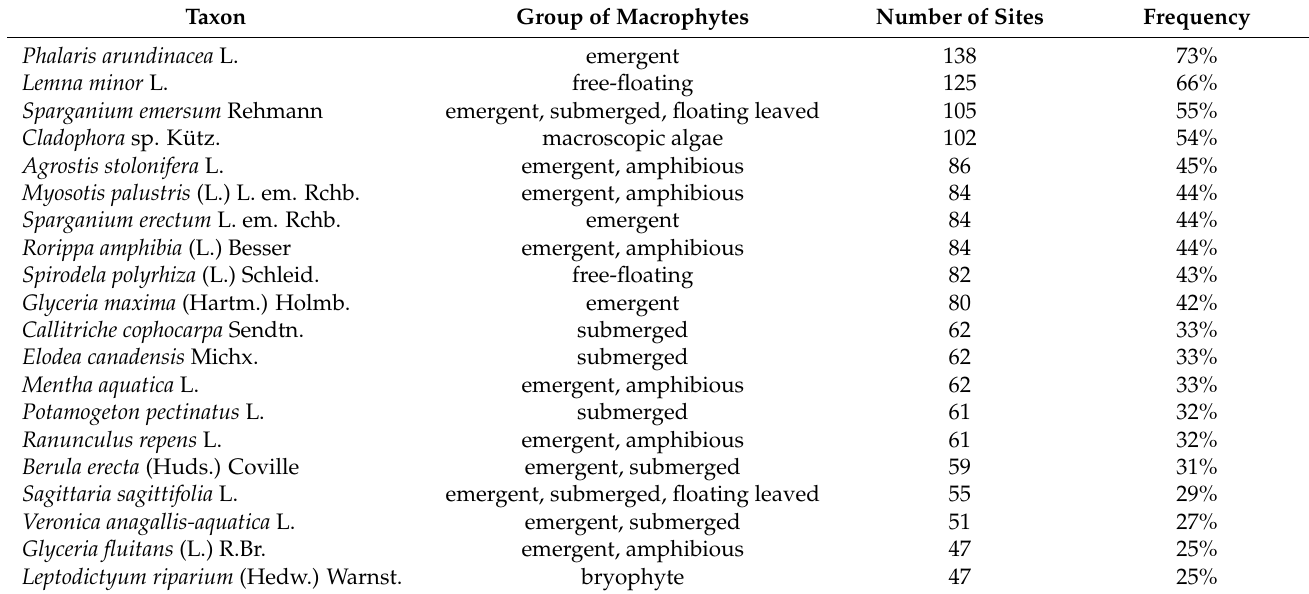
Table 2. List of the most frequent species occurring in the studied modified river stretches (frequency ≥ 25%).